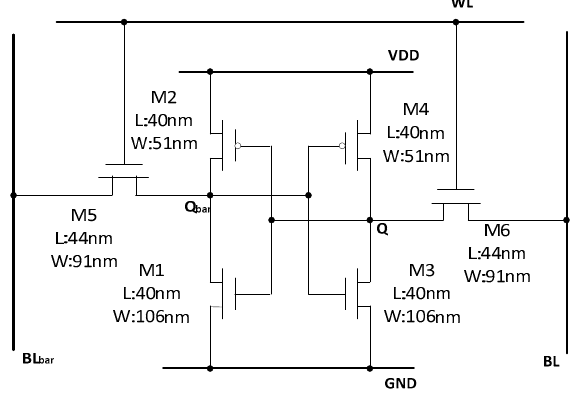
Figure 1. A bit-cell in the ST28 FDSOI SRAM with detailed size of transistors.